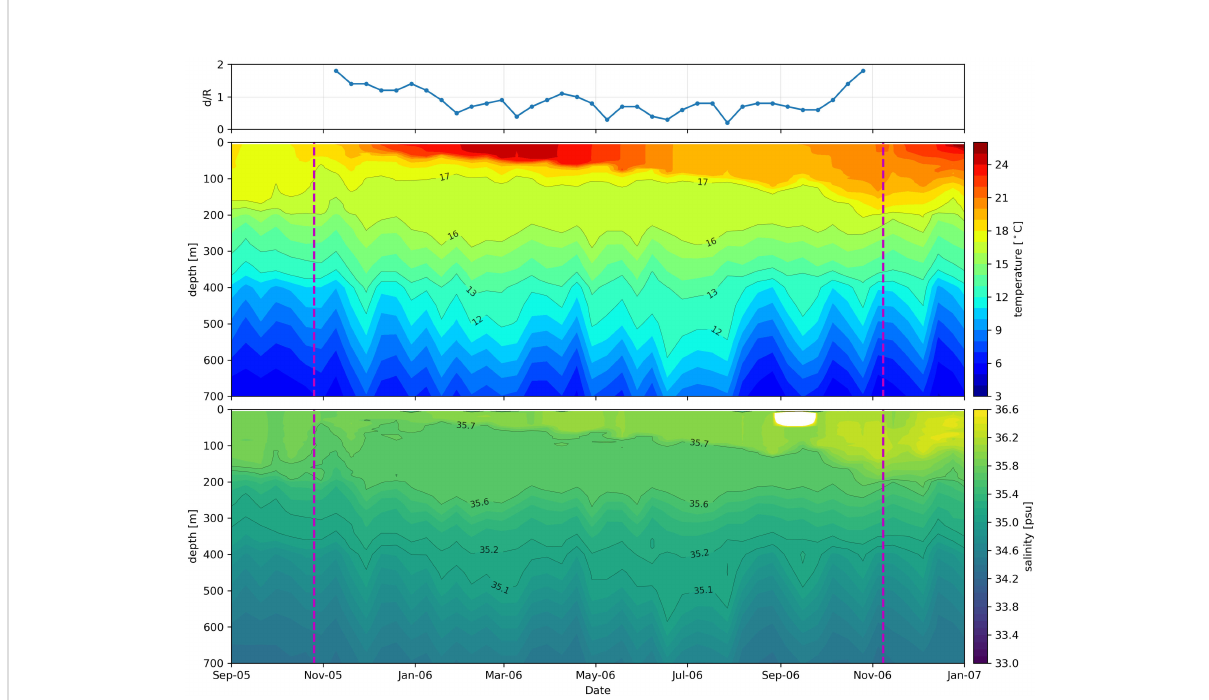
FIGURE 7 Temperature and salinity sections from Argo 1900487. Vertical dashed lines delimit the time the Argo remained inside the ring (from 09-Nov- 2005 to 25-Oct-2006). It is possible to see two thick thermostads (16-17°C and 12-13°C) and halostads (35.6-35.7 and 35.1-35.2), classi fi ed as Type I and Type II. Top panel: the ratio between pro fi le distance from the ring center and ring